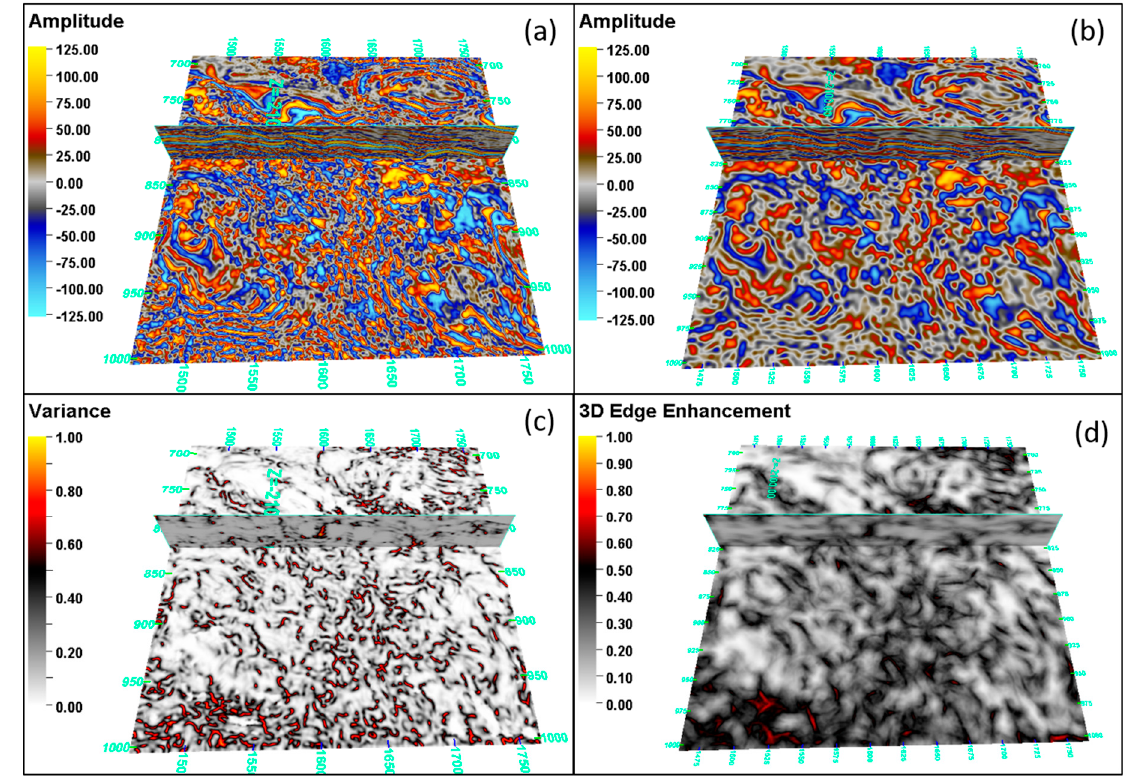
Figure 4. The result of the seismic data condition. The original seismic amplitude volume ( a ); the amplitude volume after structure smoothing ( b ); the variances attribute volume calculated after structure smoothing ( c ); and the 3D edge enhancement result to enhance the edge of the variance volume ( d ).